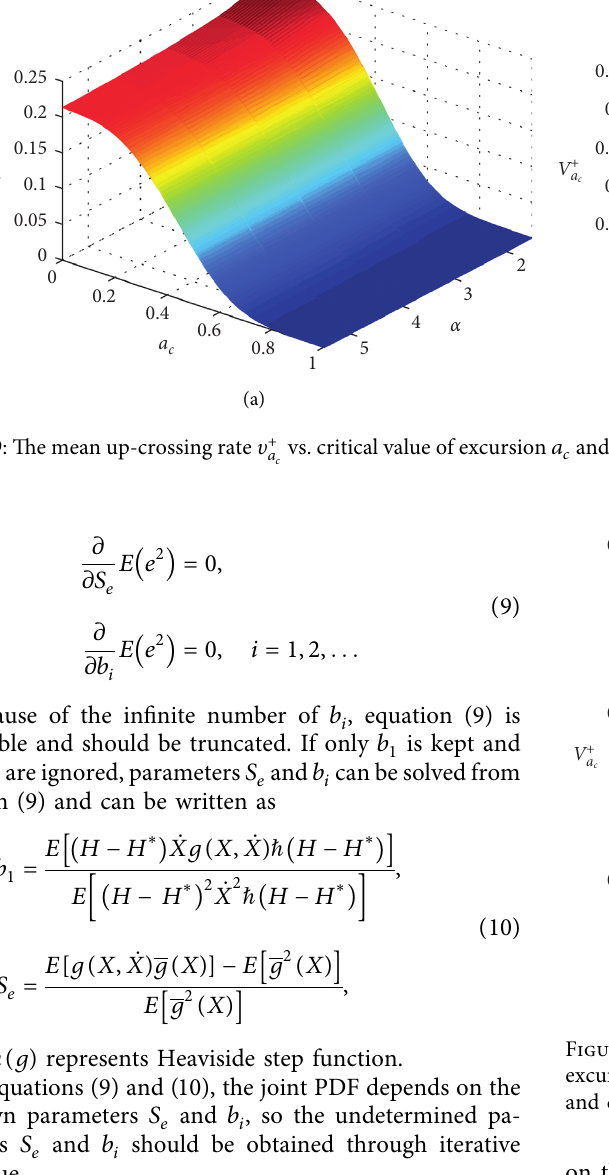
a c vs. critical value of � 1, solid lines: the analytical results, 1